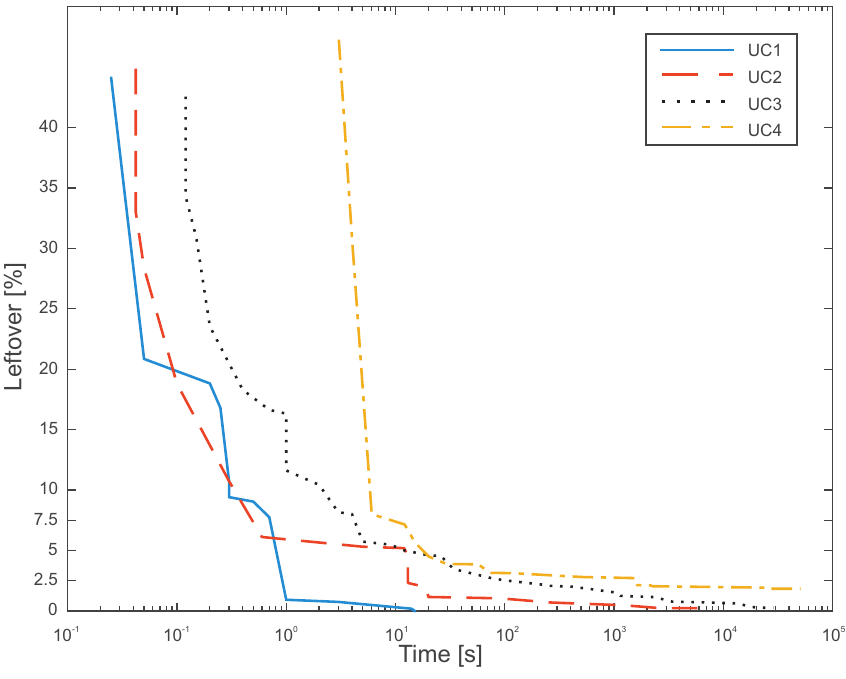
Figure 7. Validation on synthetical datasets